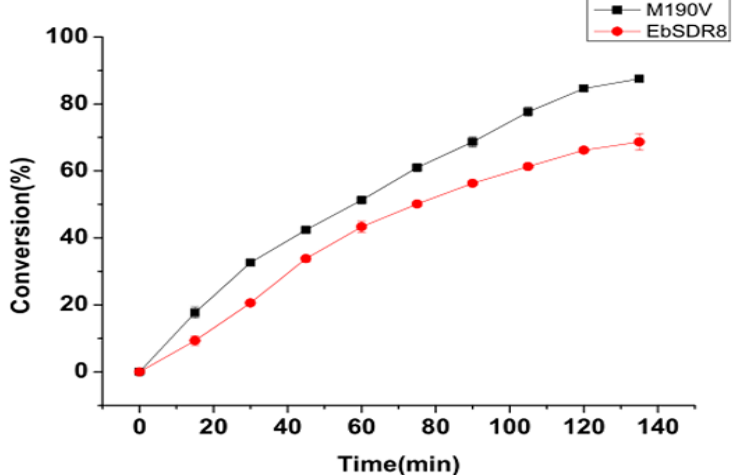
Figure 5. Time courses of M190V and wild-type EbSDR8 whole-cell-catalyzed asymmetric reduction of acetophenone. Reaction condition: 1% isopropanol, 0.05 g wet resting cells, and 200 mM of acetophenone in 500 μL reaction mixture, 35 °C. The conversion of wild-type EbSDR8 is shown in red circles, while that of the variant M190V is shown in black squares. Error bars indicate the standard deviations.